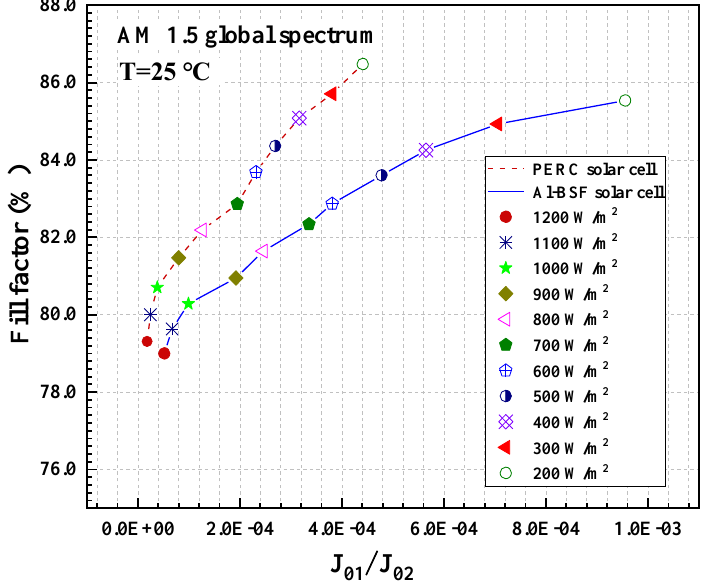
Figure 10. Variation in fill factor (FF) with the J 01 / J 02 ratio for PERC and Al-BSF silicon solar cells under different injection levels.